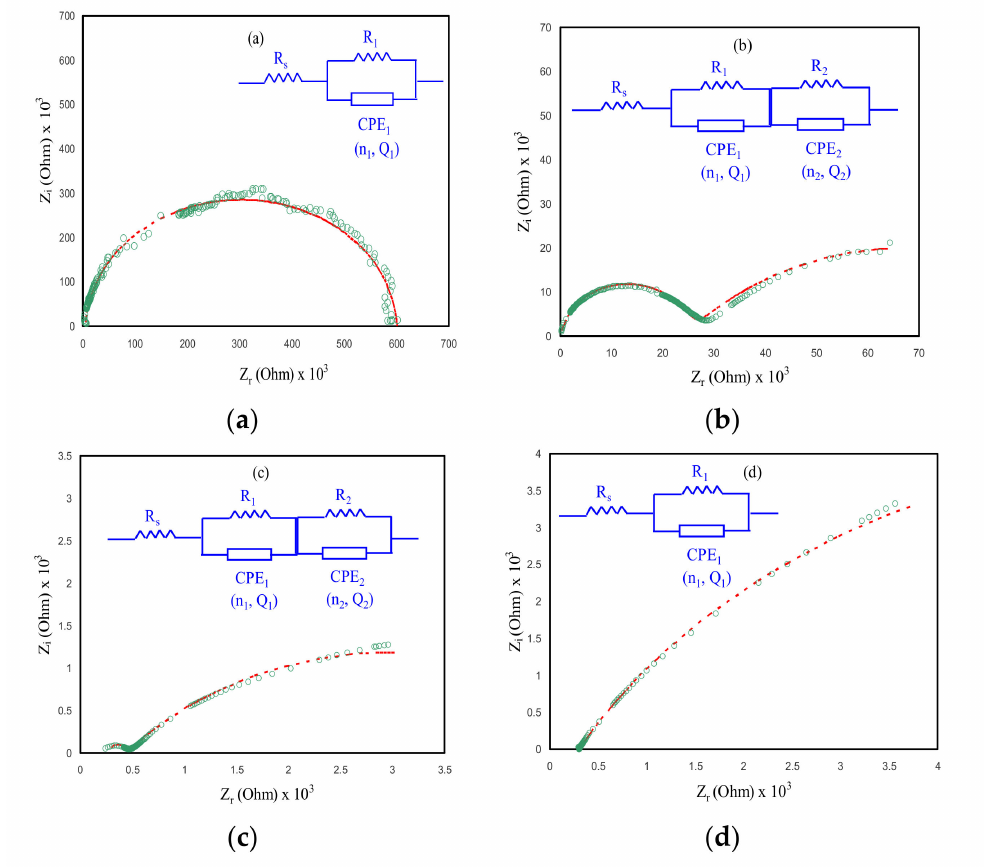
Figure 6. Impedance plots of NCSPEs at ambient temperature for ( a ) CSAG1, ( b ) CSAG2, ( c ) CSAG3, and ( d )